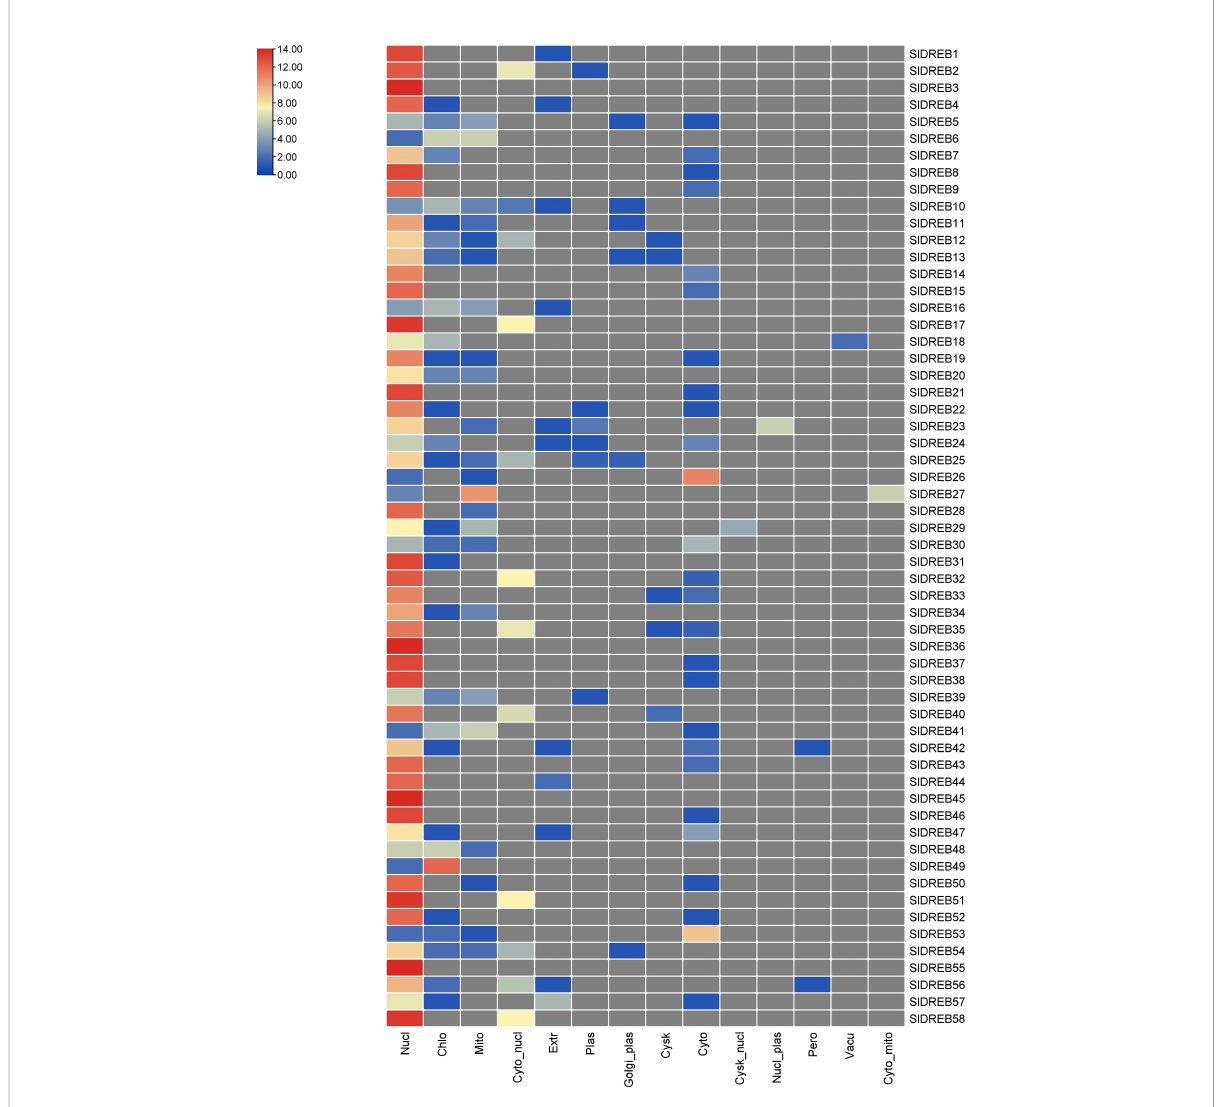
FIGURE 8 Illustration of cellular localization prediction of 58 SlDREB proteins. Each color indicates the level of abundance of SlDREB proteins in different cellular